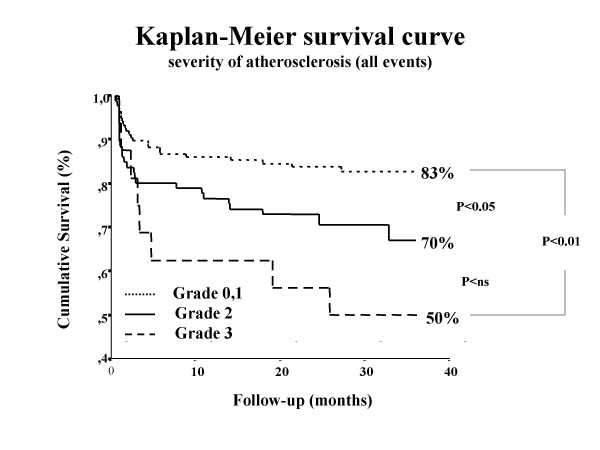
A Kaplan-Meier curve showing the association between the severity of the transesophageally detected aortic plaques and the long term survival including all events. It can be clearly seen that more severe the atherosclerosis on the descending aorta was, higher the probability of future cardiovascular events.